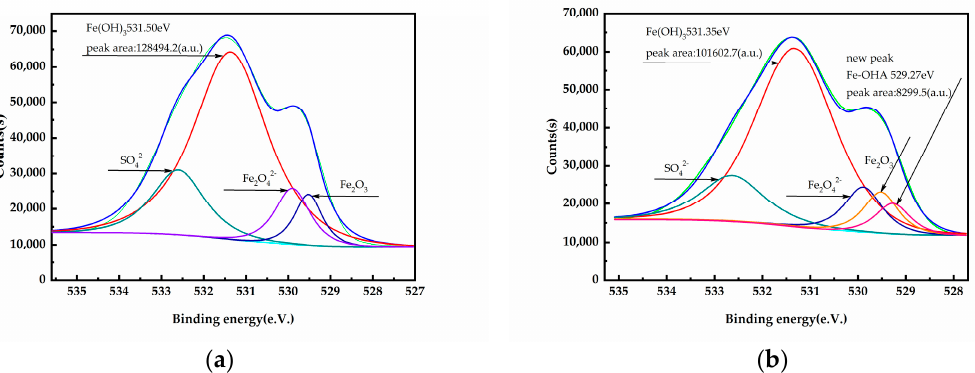
Figure 7. O1s narrow region scan of ( a ) pyrrhotite (ET = 24 h) and ( b ) pyrrhotite (ET = 24 h) treated with OHA (OHA concentration: 5 × 10 − 4 mol/L, pH = 8.0).